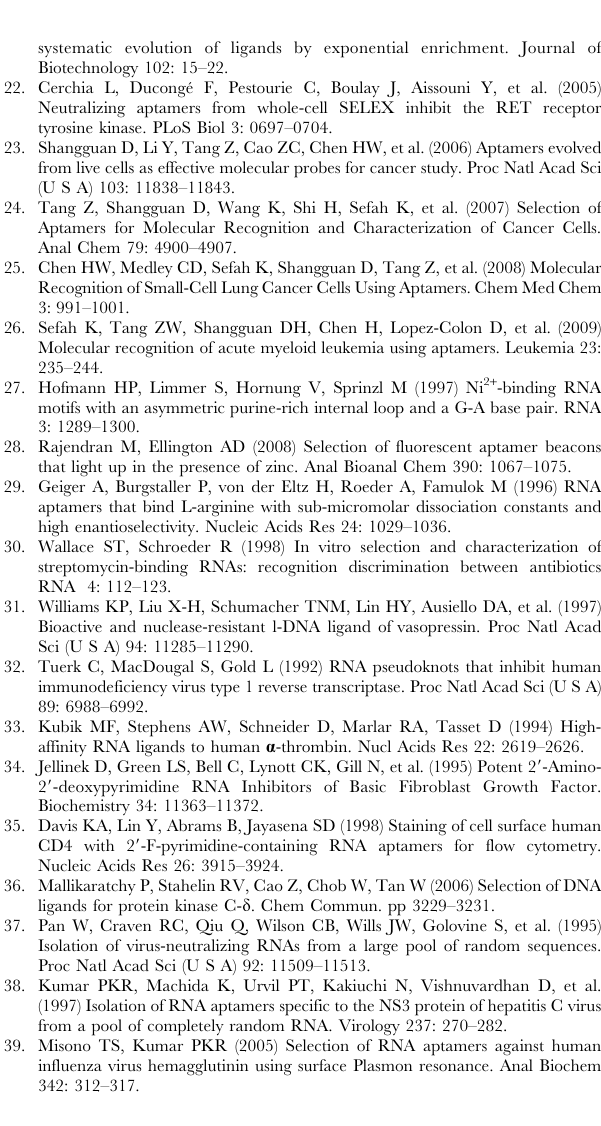
Figure S5 Assessment of the binding of selected aptamers at 37 u C. Red color represents cell background; green (unselected library) and blue (aptamer signal). Found at: doi:10.1371/journal.pone.0014269.s005 (1.39 MB TIF) Figure S6 Selected aptamers were incubated with cells using culture medium RPMI-1640 as the binding medium. Red (unselected library background); Blue (aptamer signal using PBS binding buffer) and Green (aptamer signal in RPMI-1640). Found at: doi:10.1371/journal.pone.0014269.s006 (1.38 MB TIF) Text S1 Found at: doi:10.1371/journal.pone.0014269.s007 (0.04 MB